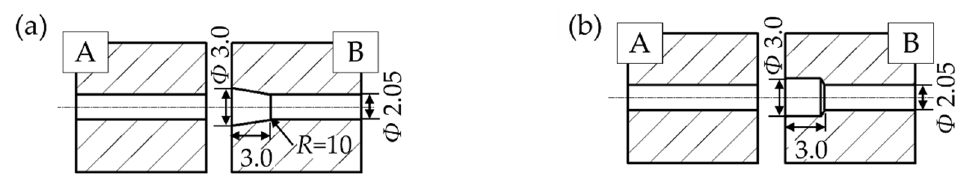
Figure 9. Geometry and dimensions of the tube hydroforming dies used in this study: ( a ) a taper-cavity die; ( b ) a cylinder-cavity die.